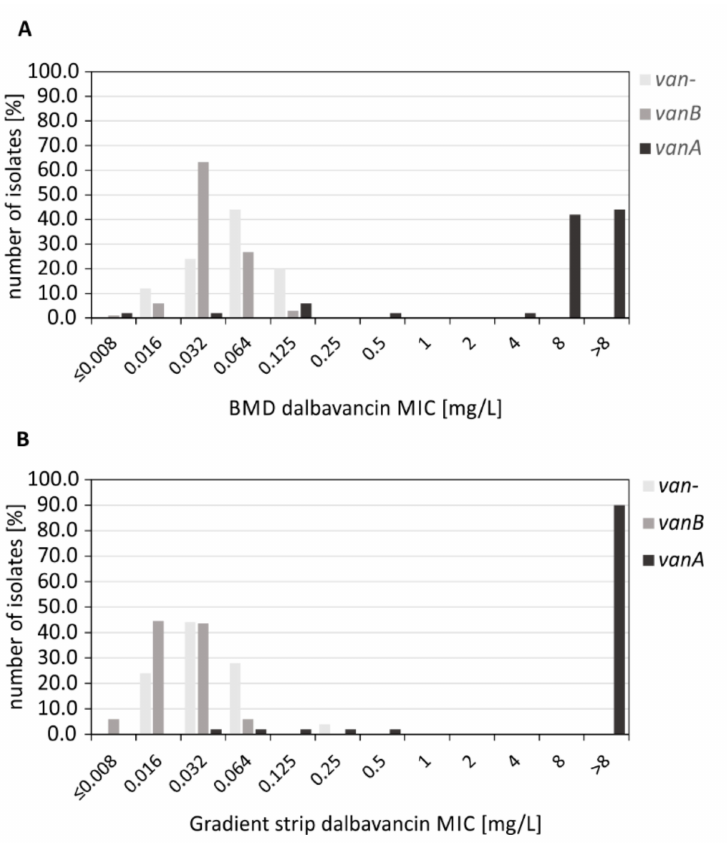
Figure 1. Distribution of dalbavancin MICs. MICs were obtained for 25 vancomycin-susceptible, 50 vanA -positive, and 101 vanB -positive E. faecium isolates using BMD ( A ) and MIC test strips ( B ). The number of isolates with corresponding MICs is given in %. Gradient strip MICs were both extrapolated to the next double dilution value equivalent to values for BMD and downsized to a maximum of >8 mg/L. The MIC breakpoint for dalbavancin for E. faecalis according to CLSI is ≤ 0.25